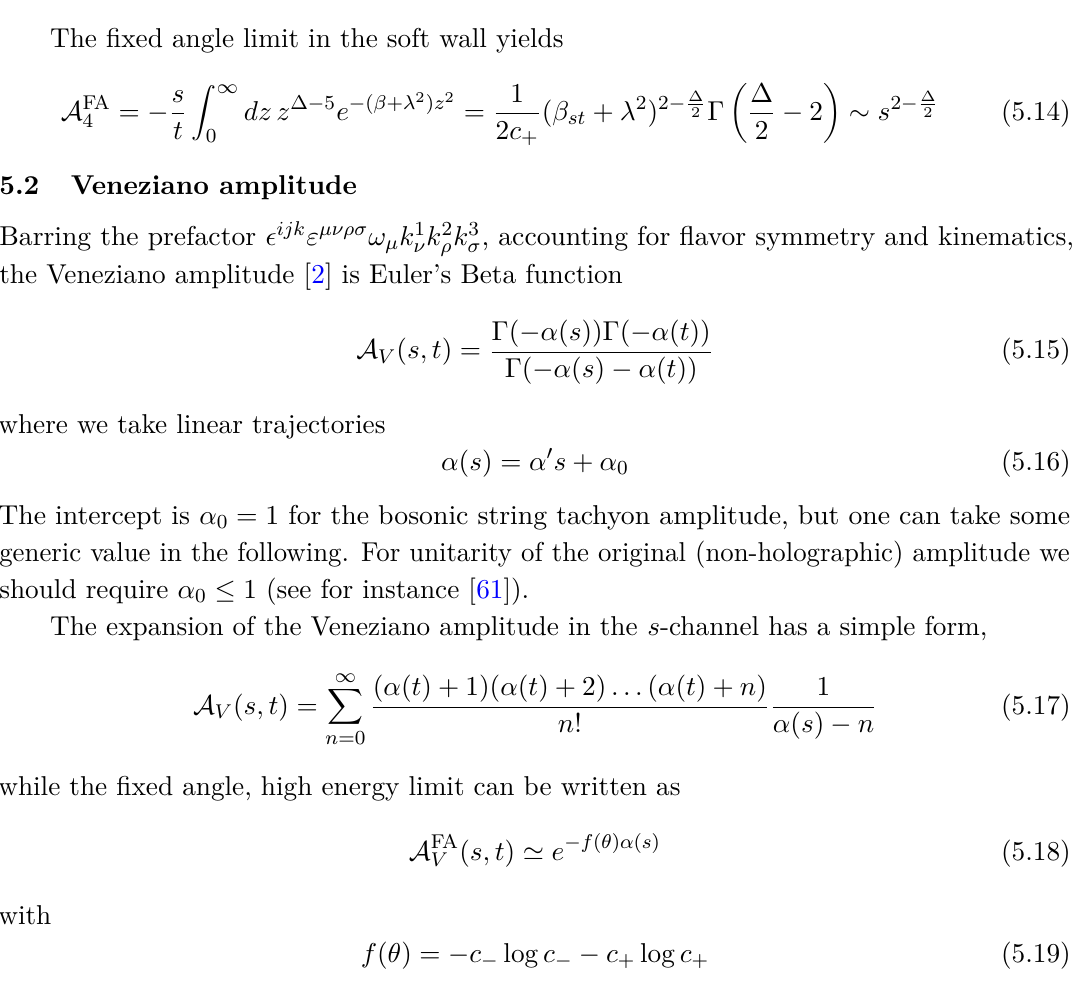
Figure 8 . Real and imaginary parts of the open string amplitude in the soft wall at different values of cosθ